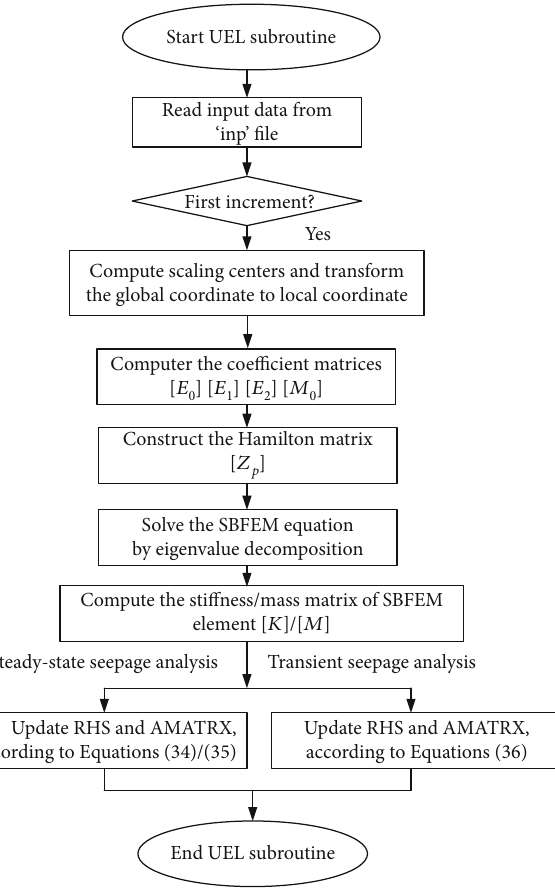
End UEL Figure 2: Flow chart of the UEL subroutine for the PSBFEM.